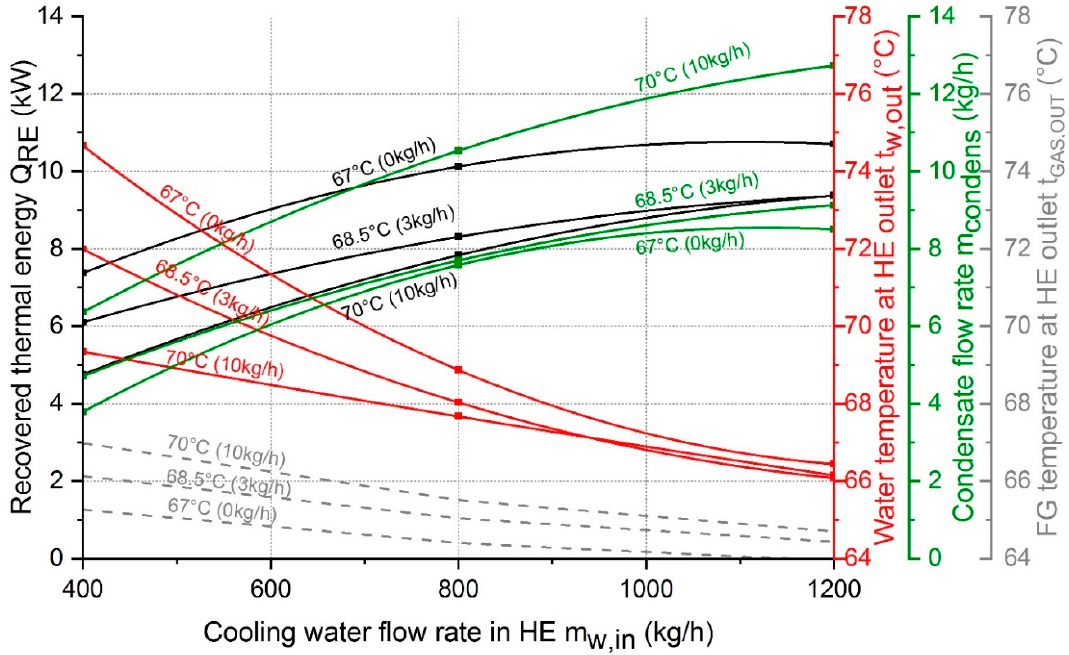
Figure 5. Influence of the cooling water flow rate in the heat exchanger (HE) and the dew point temperature on the recovered thermal energy (black lines), the water temperature at the HE outlet (red lines), the condensate flow rate (green lines) and the flue gas temperature at the HE outlet (gray lines) for concept 1.